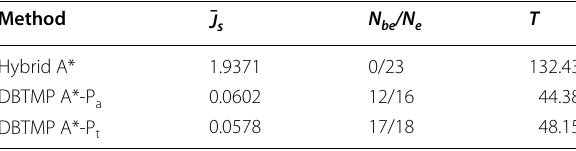
Table 3 Comparison of MP online selection results in a